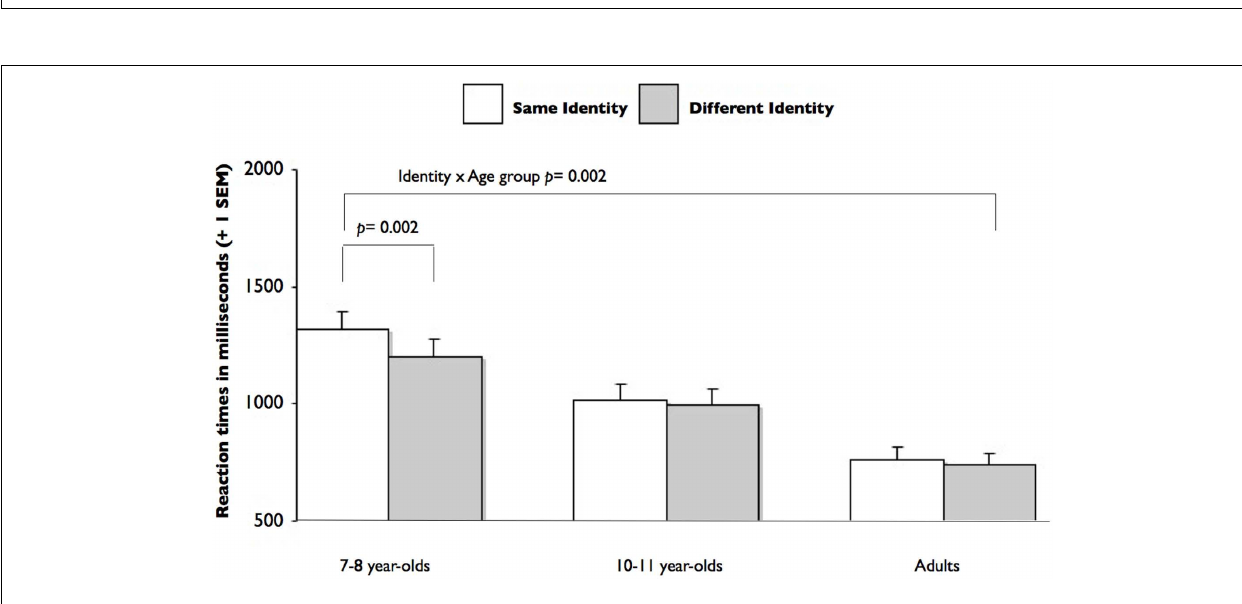
FIGURE 5 | Experiment 2: two-way interaction for identity × age group in the reaction times. The interaction was due to the 7- to 8-year-olds taking significantly longer to decide that the identity had not changed from the first to the second face than the other two age groups.